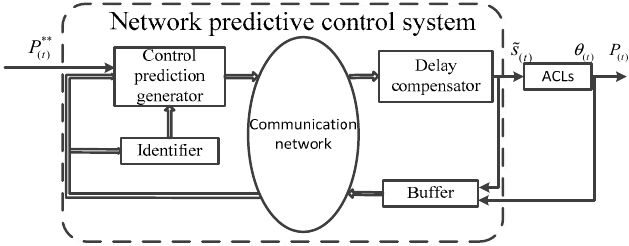
Figure 5. Diagram of the network predictive control system